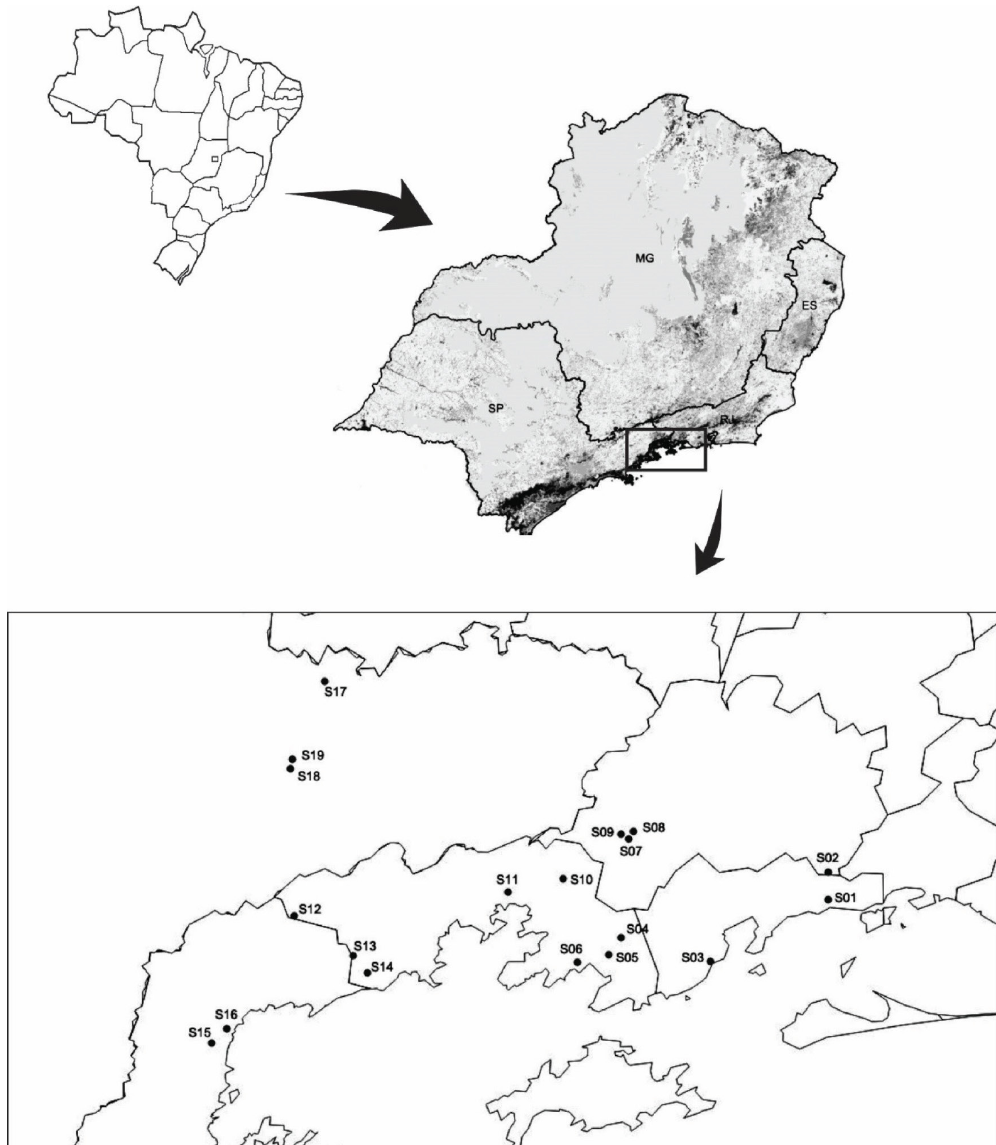
Figure 1. Map of Southeastern Brazil region highlighting the Southern of Rio de Janeiro state and the North of São Paulo state with the sampling